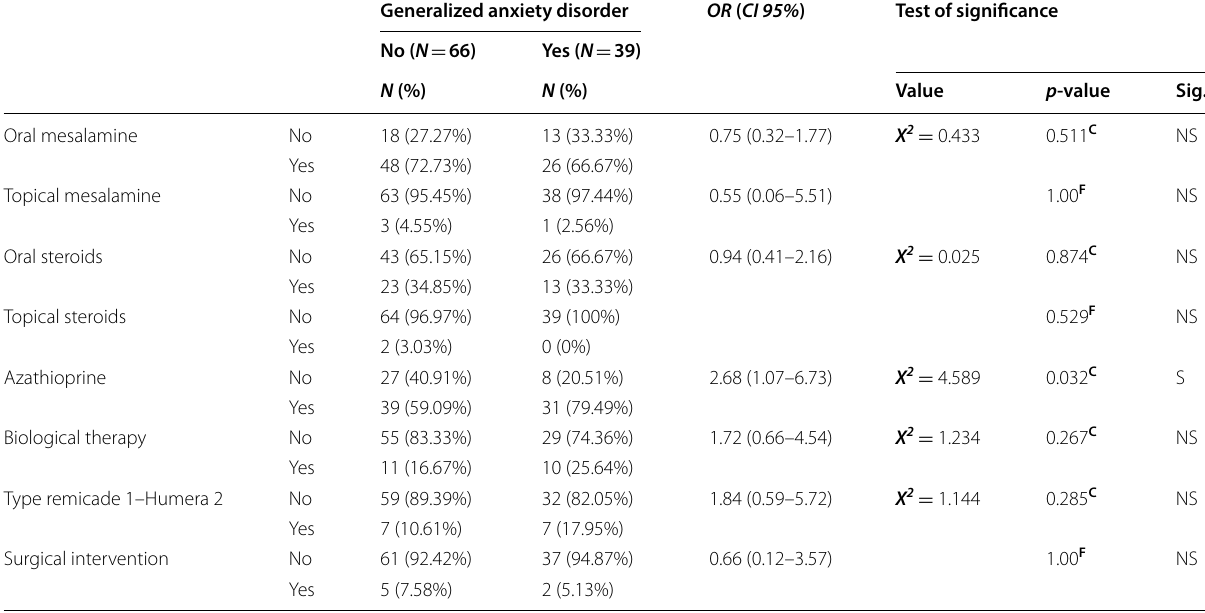
Table 9 Multivariate logistic regression analysis of the relationship between treatments received by the patient and generalized anxiety